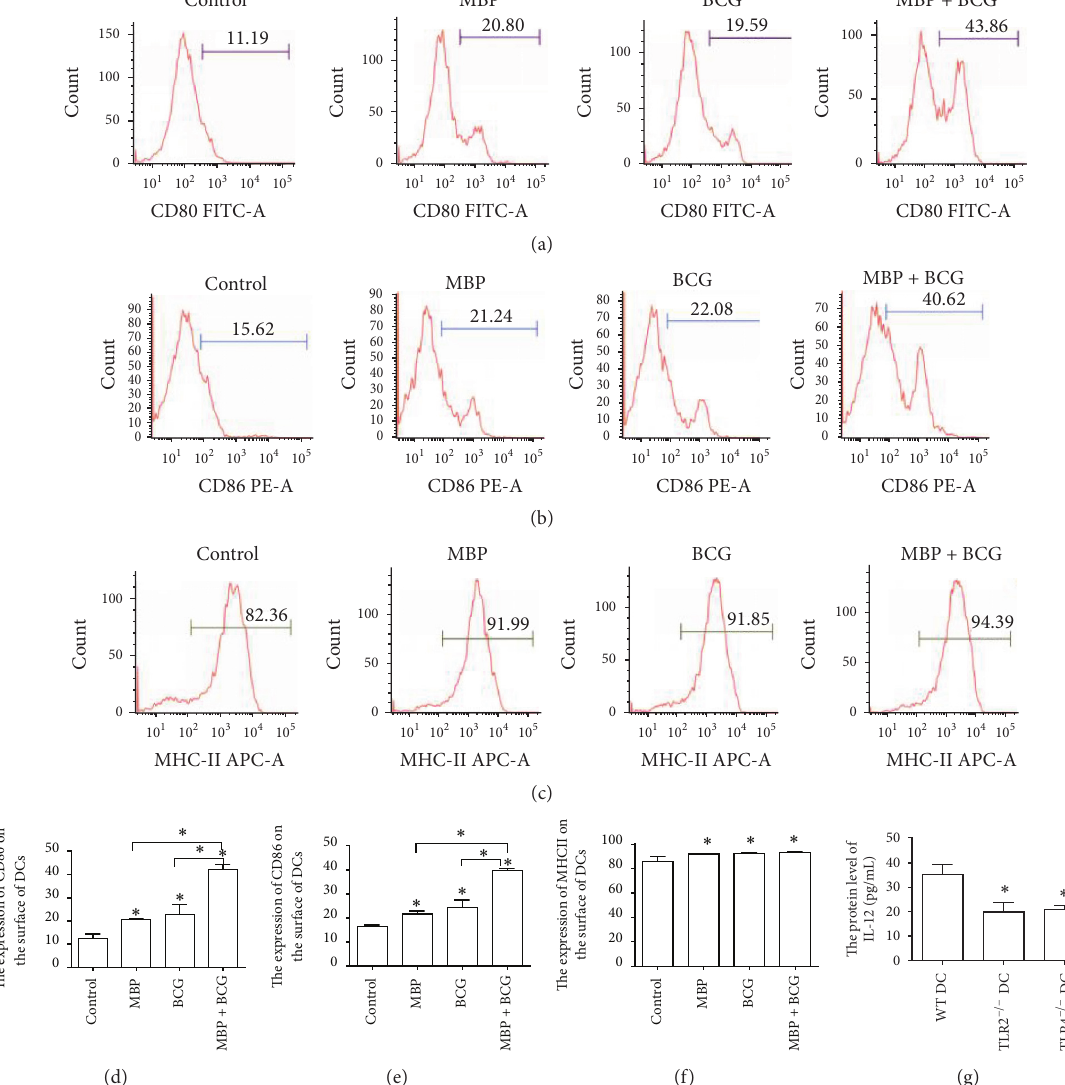
Figure 2: The combination of MBP and BCG upregulates CD80, CD86, and MHC class II expression on the surface of DCs and increased the production of IL-12 protein. Splenic DCs from normal mice (1 × 10 6 cells/mL) were cultured with MBP, BCG, or the combination of MBP and BCG for 48 h and were analyzed using flow cytometry. DCs collected from the different groups were stained with the following antibodies: FITC-conjugated anti-CD80 (a), PE-conjugated anti-CD86 (b), and APC-conjugated anti-MHC class II (c). The percentage of positive cells is shown in a flow cytometry histogram. The percentage of CD11c + cells expressing each surface molecule is expressed as the mean ± standard deviation and is shown in a bar graph (d–f). ELISA was used to detect the level of IL-12 protein in supernatant of DCs isolated from different types of mice (WT mice, TLR2 −/− mice, or TLR4 −/− mice) treatment with the combination of MBP and BCG (g). Data were derived from three independent experiments. ∗ 𝑃 < 0.05 is considered to indicate statistically significant differences, compared with control group or with WT DC